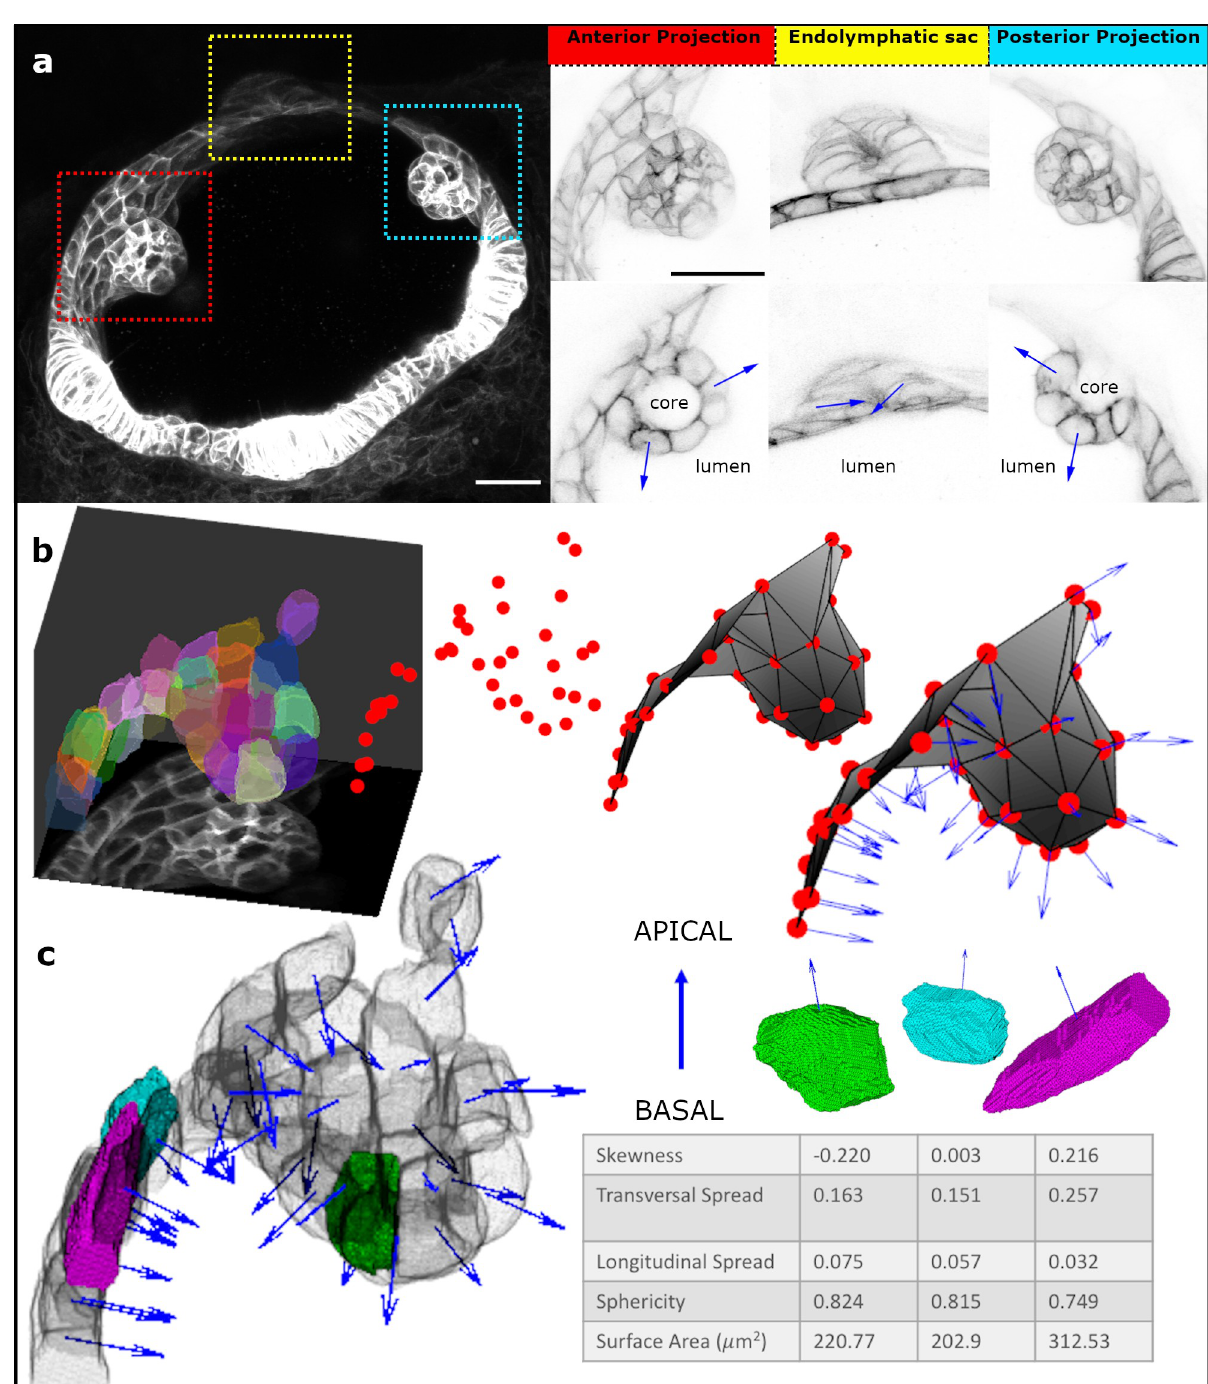
Fig 1. Origami Image Analysis Pipeline. a. Airyscan confocal fluorescence micrograph (maximum intensity projection (MIP) of 35 z-slices) of the developing zebrafish otic vesicle at 51.5 hours post fertilisation. Red box—anterior projection; yellow box—endolymphatic sac; cyan box—posterior projection. The ROIs are expanded alongside—top row MIPs, and bottom row single slices. Scale bars: 20 μ m. Blue arrows mark the direction of apicobasal polarity (pointing towards the apical side). b. Polarity assignment on segmented data; ROI surrounding the anterior projection was segmented (here overlaid on the MIP) using ACME, centroids were generated for each segmented cell and a triangular surface mesh was produced from these centroids. Normal vectors (blue arrows) to this surface mesh represent the apico-basal axis. c. Cell shape features were computed concerning the assigned apico-basal axis; here, three example cells are highlighted, alongside a 3D rendering showing their position in the anterior projection and the corresponding shape metrics in a table.